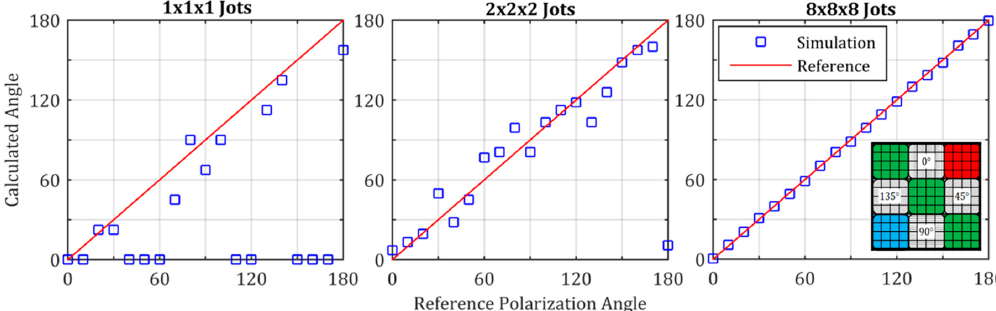
Figure 15. Illustration of polarization angle extraction from various sized cubicles of jots under each polarization-angle filter, from one Monte-Carlo simulation iteration ( H = 1) for each reference angle. Inset shows 4 × 4 jots under both polarization-angle filters and color filters, to create a 3 × 3 super- kernel to extract polarization and color information from a single-bit QIS. From